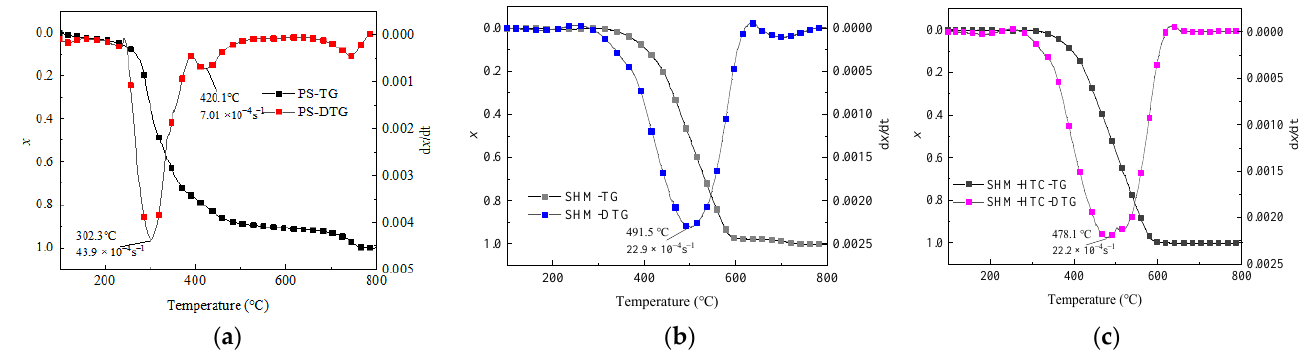
Figure 4. Conversion curves and conversion rate curves of separate sample: ( a ) PS; ( b ) SHM; ( c ) SHM-HTC. Table 3. Results of combustion reaction parameters for PS, SHM, SHM-HTC and their blend.